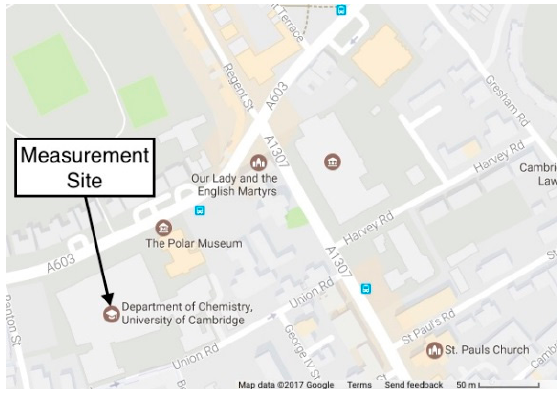
Figure 3. Map showing the location of measurement site in Cambridge, UK. Courtesy of Google Maps.